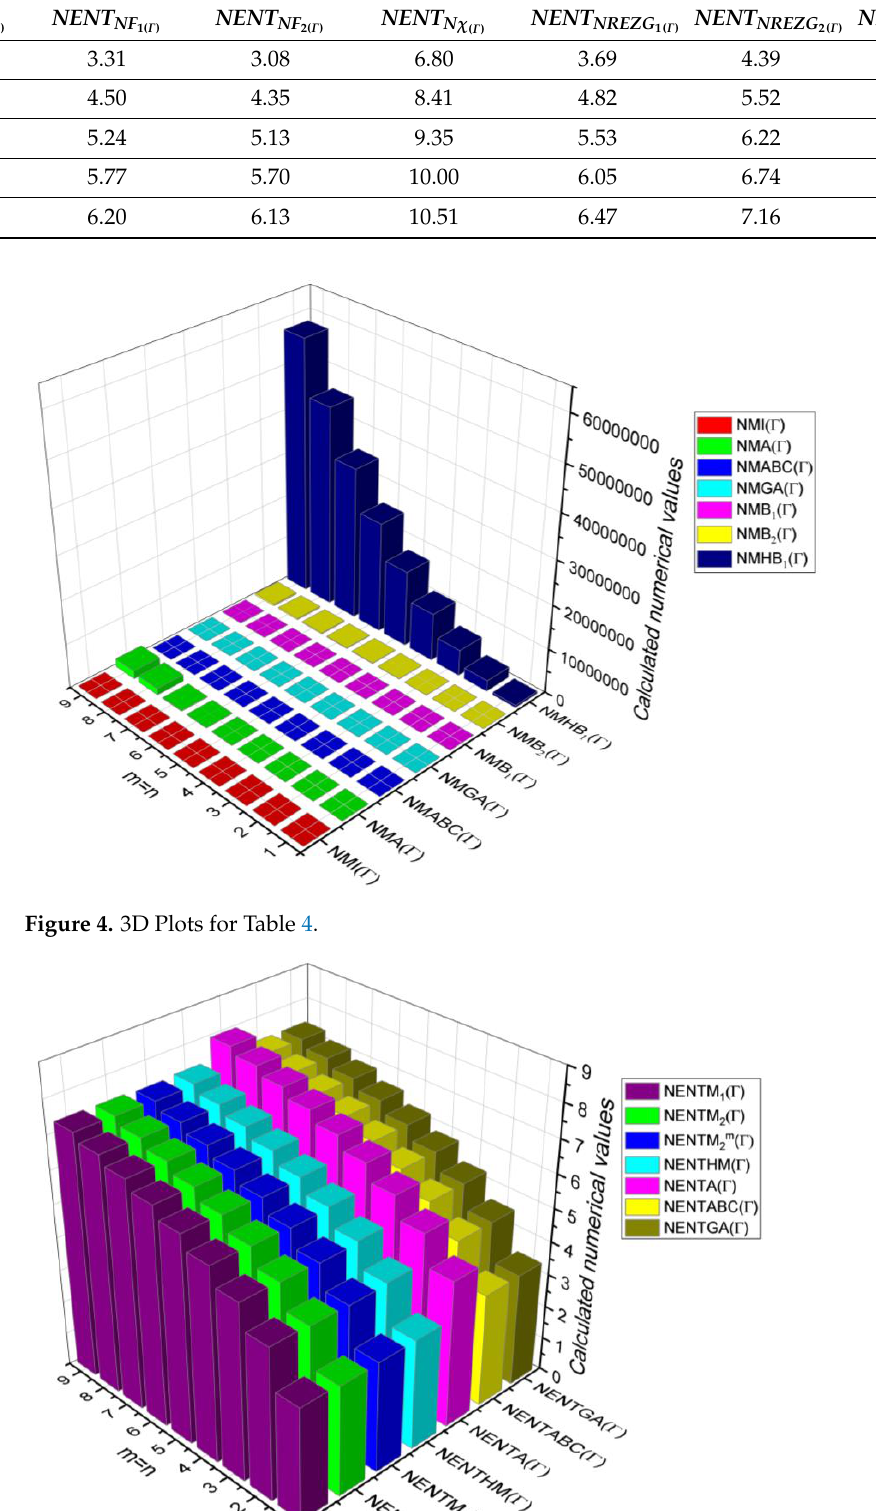
Figure 6. 3D Plots for Table 6. Table 5. Comparison Table for Theorem 3. 𝒎 = 𝒏